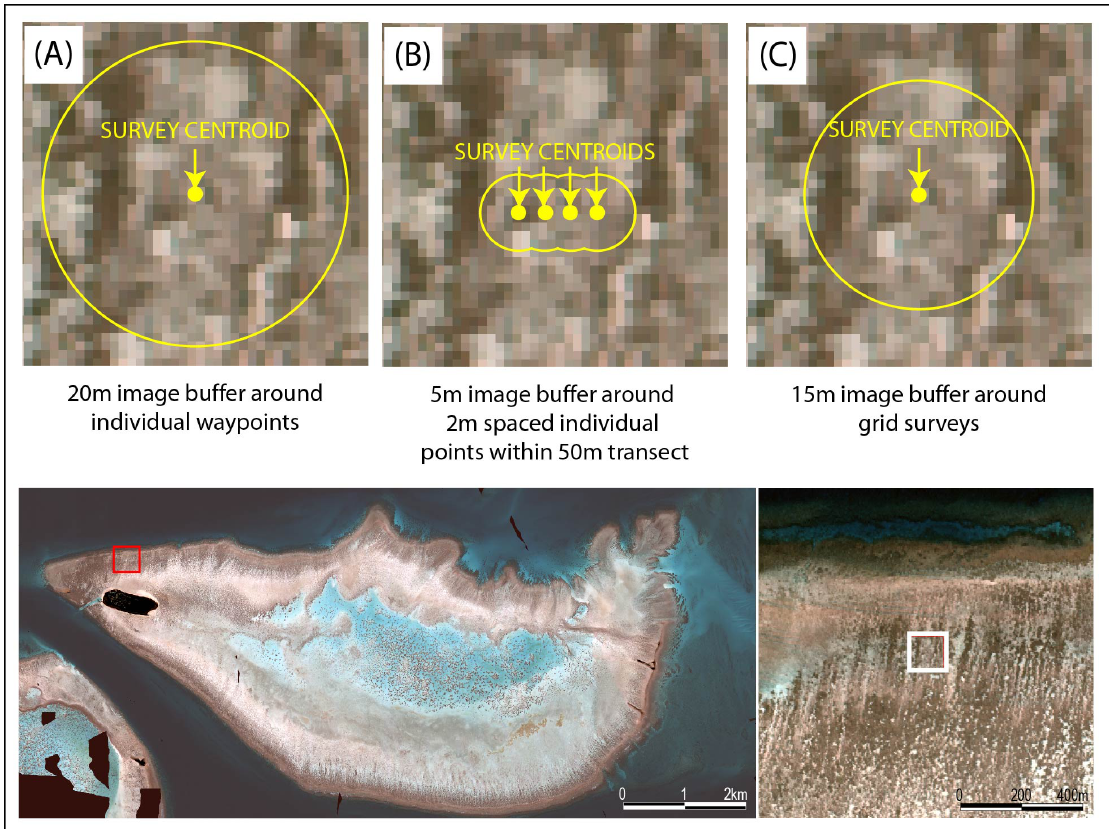
Figure 3. Buffer creation around ( A ) discrete sampling points; ( B ) transect surveys; and ( C ) grid